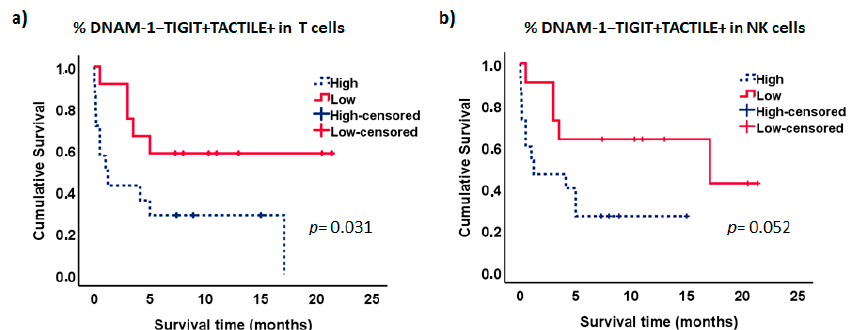
Figure 9. Kaplan–Meier survival analysis in AML patients. AML patients ( n = 26) were stratified according to the co-expression of TIGIT and TACTILE on DNAM-1 negative CD56 − T lymphocytes ( a ) and DNAM-1 negative NK cells ( b ). Blue dotted lines correspond to patients with high percentage of DNAM-1 − TIGIT + TACTILE + cells and red lines to patients with low percentage of DNAM-1 − TIGIT + TACTILE + cells. Censored patients are indicated as tick